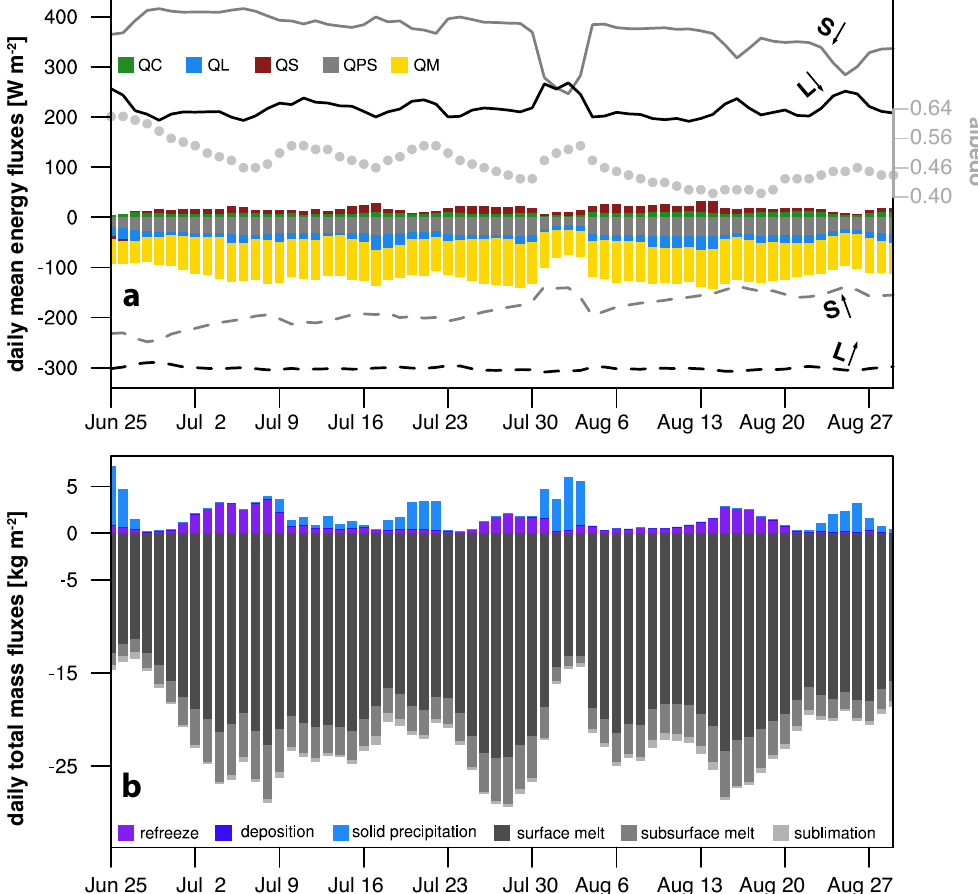
Fig. 9. From the interactive WRF-CMB simulation: daily (a) mean surface energy balance components (left y-axis; see Eq. 1 for explanation of symbols) and albedo values (grey right y-axis), and (b) sums of mass fluxes. The radiation variables are shown in (a) as solid (directed downward) and dashed (upward) lines, albedo as grey dots, and the other surface energy fluxes as bars. The heat flux from precipitation (QPRC) is negligible and not shown. Values are averaged over glaciated grid cells only.